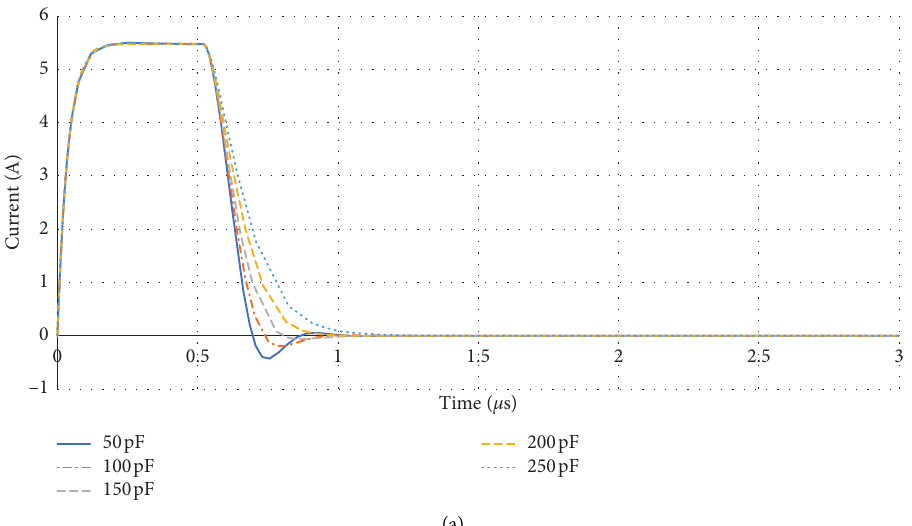
line during turn-off.